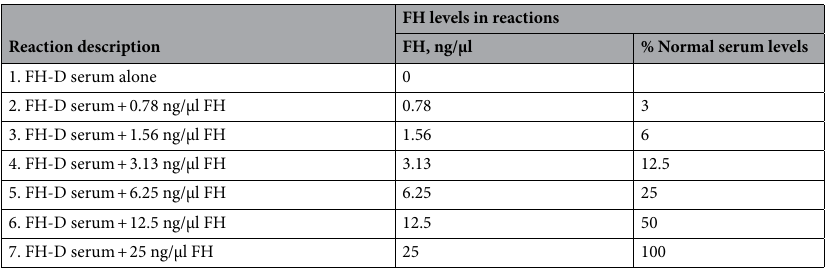
Table 2. FH additions and concentrations in FH-D serum reactions. AP activation was measured in FH-depleted serum reactions with the addition of increasing amounts of FH. Table 3 shows the final FH concentrations in the FH-D serum reactions, along with comparable FH levels in normal serum. C3a and Ba levels were measured after 15 min at 37 °C. The results are in Fig. 2.